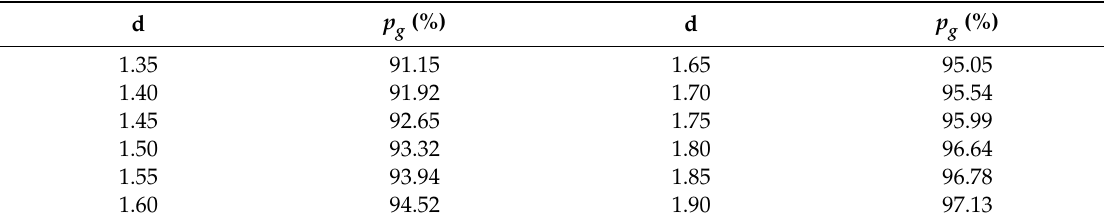
Table 4. Probability degree and guaranteed